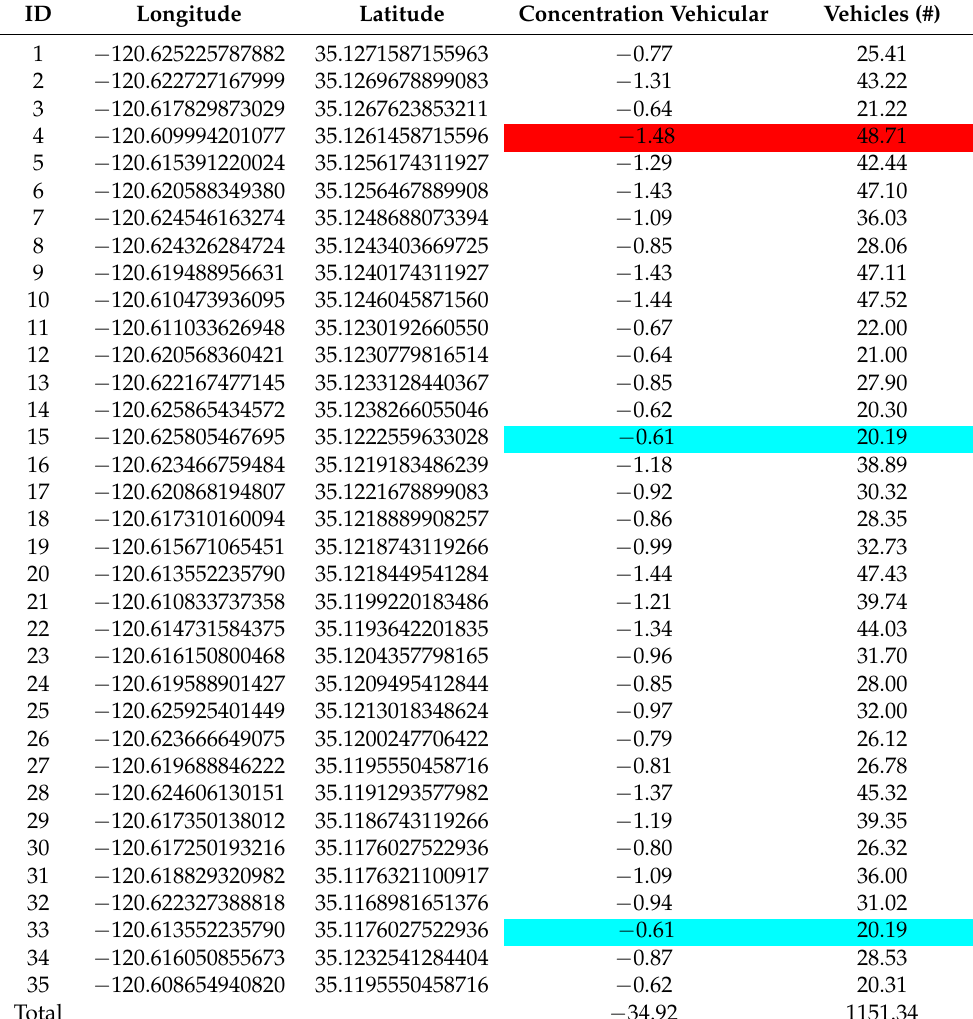
Table 6. Case A: Maximum partial demand in each CS at hour 19:00 with 32.97 km of road network in contingency N-0 corresponding to year